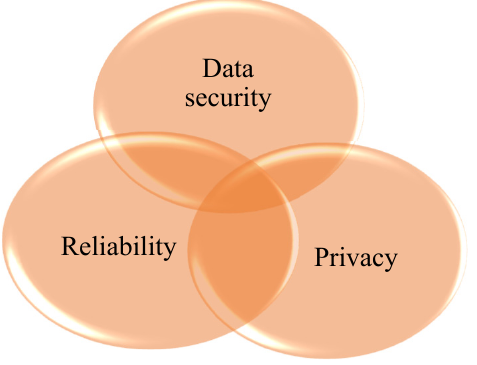
Figure 8. Security Flaws.